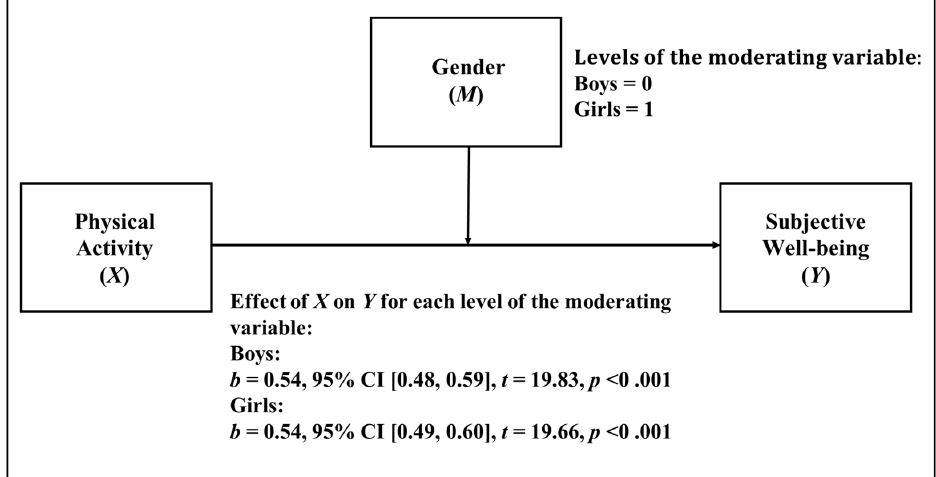
Table 3. Regression analysis of SWB on PA, considering the moderating effect of gender.